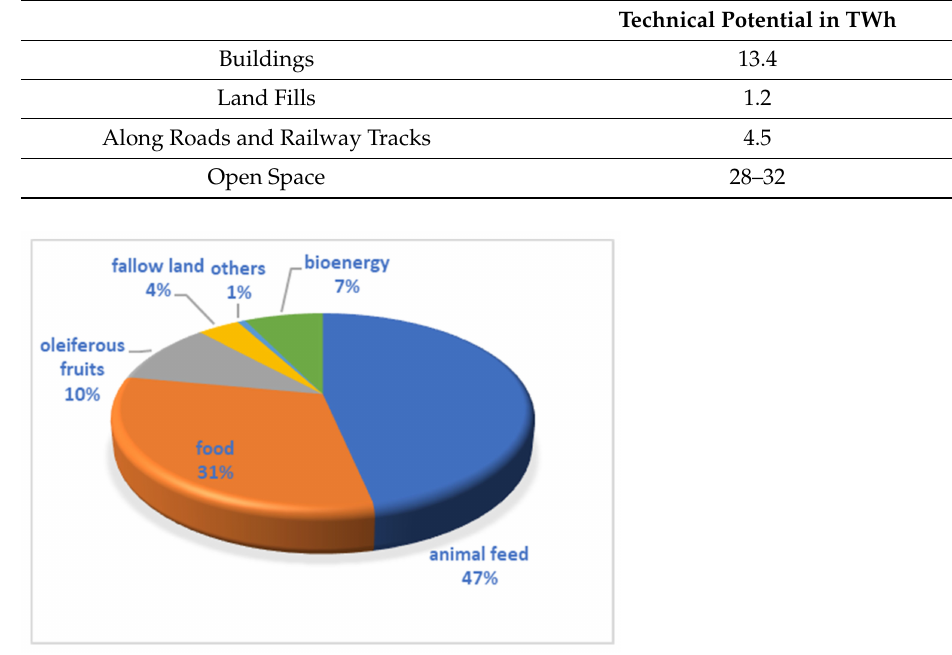
Figure 8. Usage of agricultural area in Austria in 2017 (based on [72] with permission from Österre- ichischer Biomasse-Verband